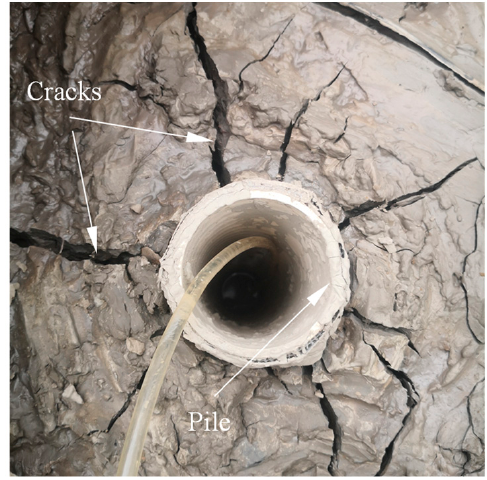
Figure 16. Cracks in the soil around the